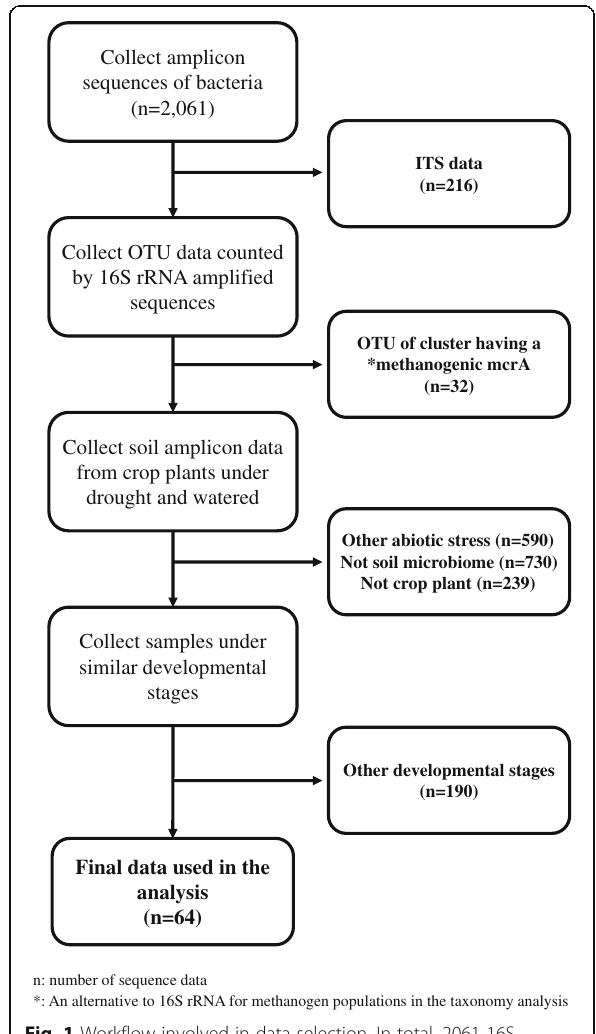
Fig. 1 Workflow involved in data selection. In total, 2061 16S amplicon sequence datasets were collected from the National Center for Biotechnology Information (NCBI, https://www.ncbi.nlm. nih.gov/) and the European Molecular Biology Laboratory – The European Nucleotide Archive (EMBL-ENA, https://www.ebi.ac.uk/ena). Internal Transcribed Spacer (ITS) and methanogenic mcrA data were first removed. Then, abiotic stress data other than drought stress- treated root microbiome data and non-crop plant data were excluded. Finally, by removing data sampled at different developmental stages, we reanalyzed amplicon sequence data of crop plants under drought stress and at similar developmental